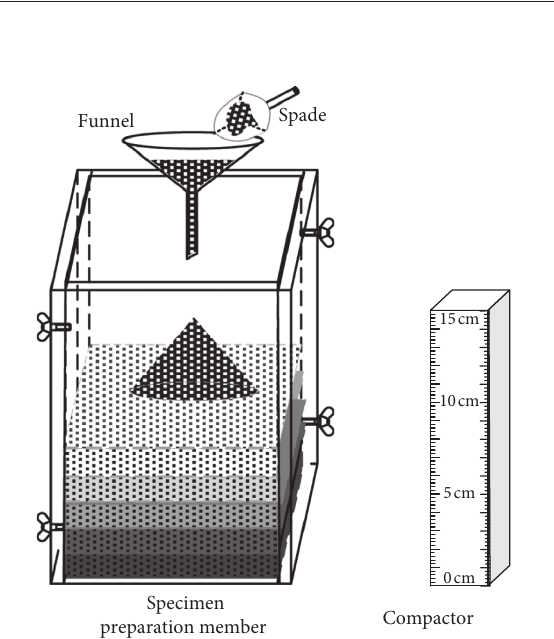
Figure 4: Specimen preparation by layering dry